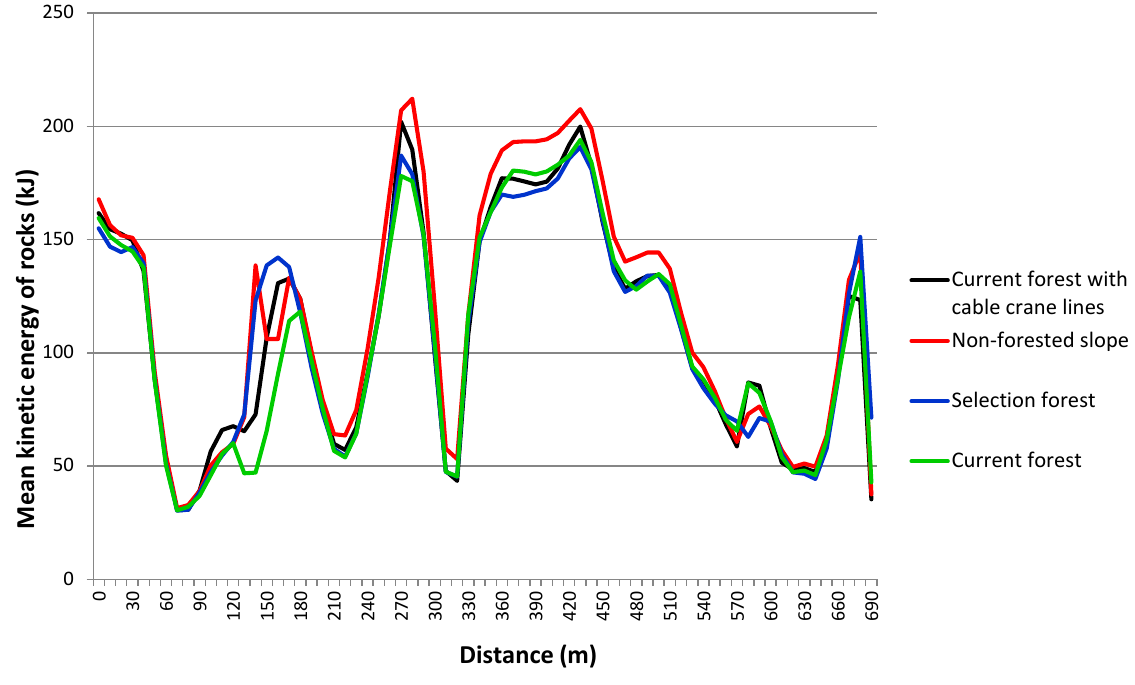
Figure 4. Profile chart of mean kinetic energy in kilojoule (kJ) of rocks on the main road for four forest management scenarios. Distance was measured along the regional road from the tunnel and plateau indicated on the left hand side of the Figure 2 towards sharp bend on the right hand